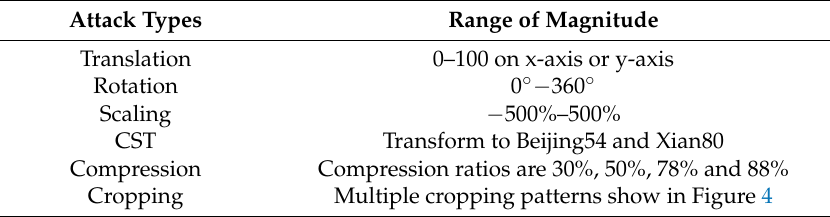
Table 2. Magnitudes of attacks. CST: Coordinate System Transformation.